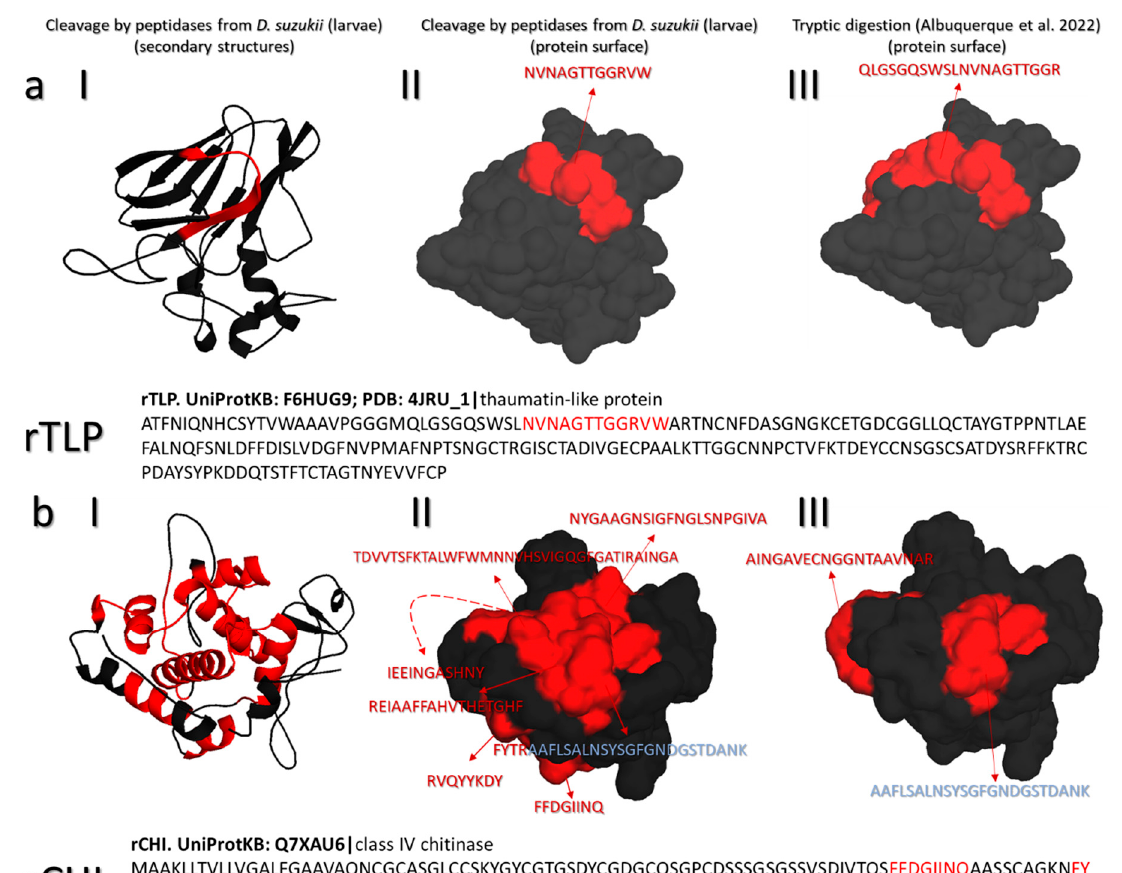
Figure 3. Cleavage sites in rTLP and rCHI detected after digestion with the purified peptidases from the D. suzukii larvae. The cleaved peptides from ( a ) rTLP and ( b ) rCHI are displayed separately as ( I ) cleaved peptides identified in secondary structures and ( II ) cleaved peptides identified on the protein surface. ( III ) The same protein structure is shown cleaved by a trypsin. For each recombinant protein, the identified peptides are also highlighted in red in the amino acid sequence.